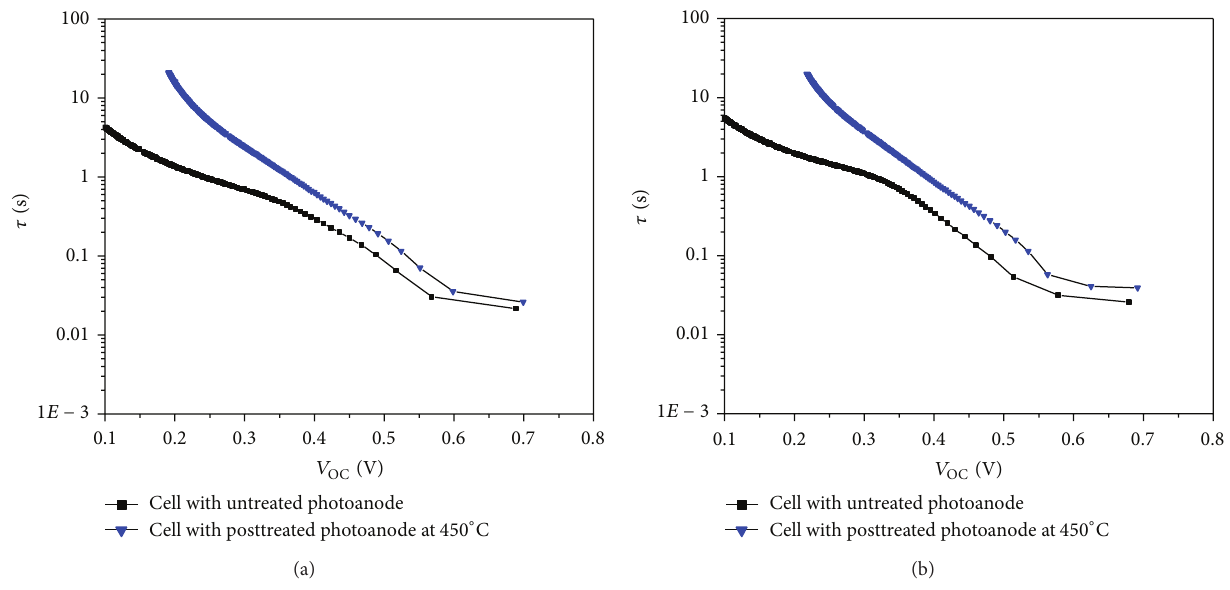
Figure 7: Electron lifetime as a function of the 𝑉 of DSSC with untreated photoanode (black full square) and posttreated photoanode with OC colloidal treatment at 450 ∘ C (blue full inverted triangle), with Solaronix electrolyte: (a) without a compact layer; (b) with a compact